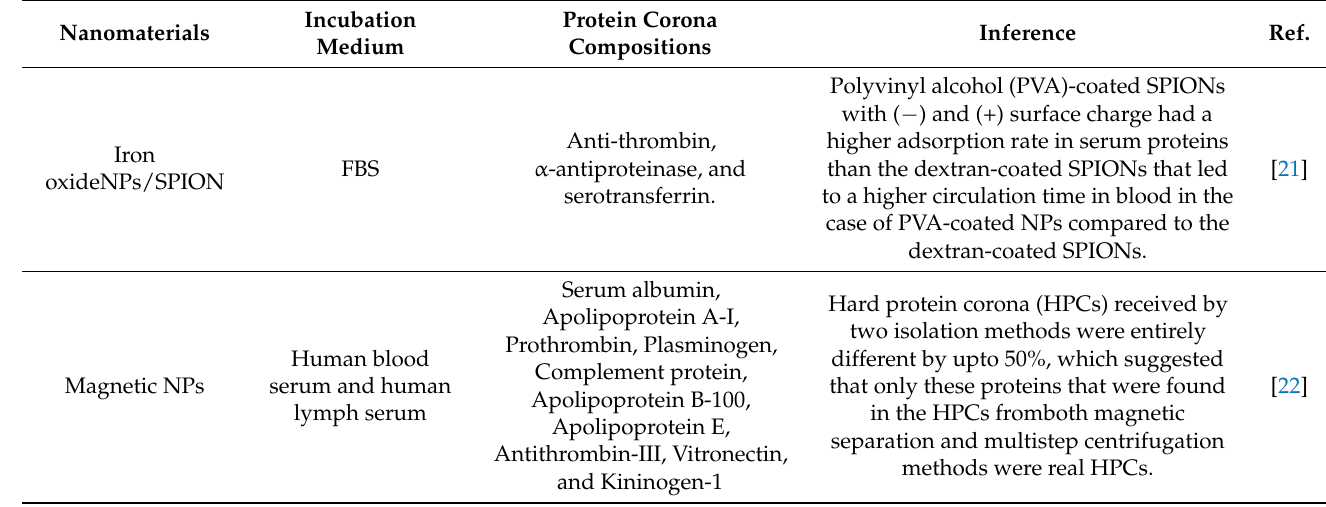
Table 2. Some examples of nanomaterials integrating with proteins forming corona in blood plasma/serum.